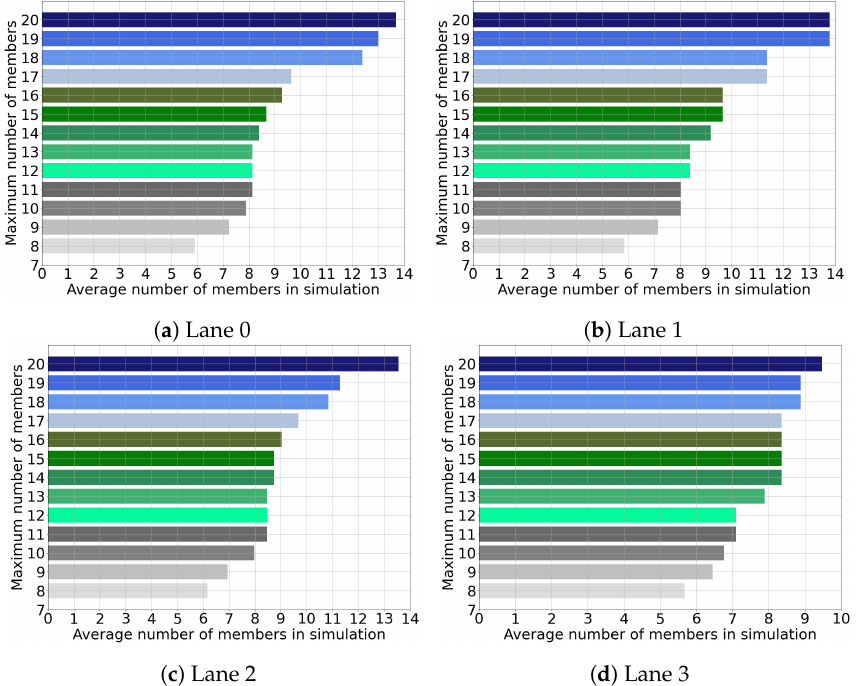
Figure 5. The average platoon size in Lane 0 to Lane 3 in three scenarios of simulations.